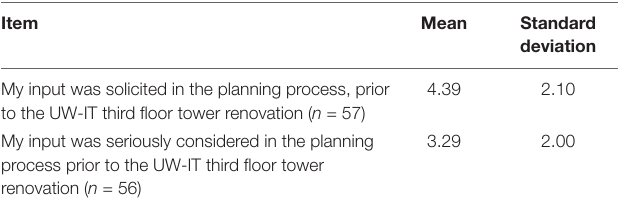
TABLE 5 | Descriptive statistics for items measuring participatory satisfaction with their environment at work after renovation (Time